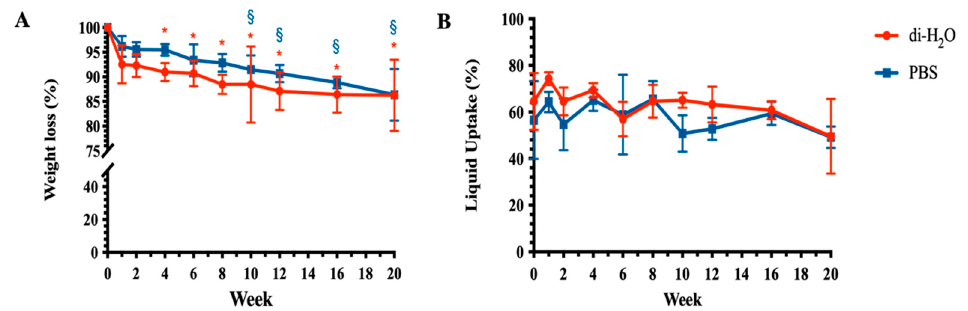
Figure 3. ( A ) Weight loss and ( B ) liquid uptake of electrospun PLGA scaffolds degraded in PBS and di-H 2 O solutions at 37 ◦ C up to 20 weeks. * and § statistically significant vs. week 0 ( p < 0.05). Statis ‐ tical symbols in blue and red refer to di ‐ H 2 O and PBS, respectively.